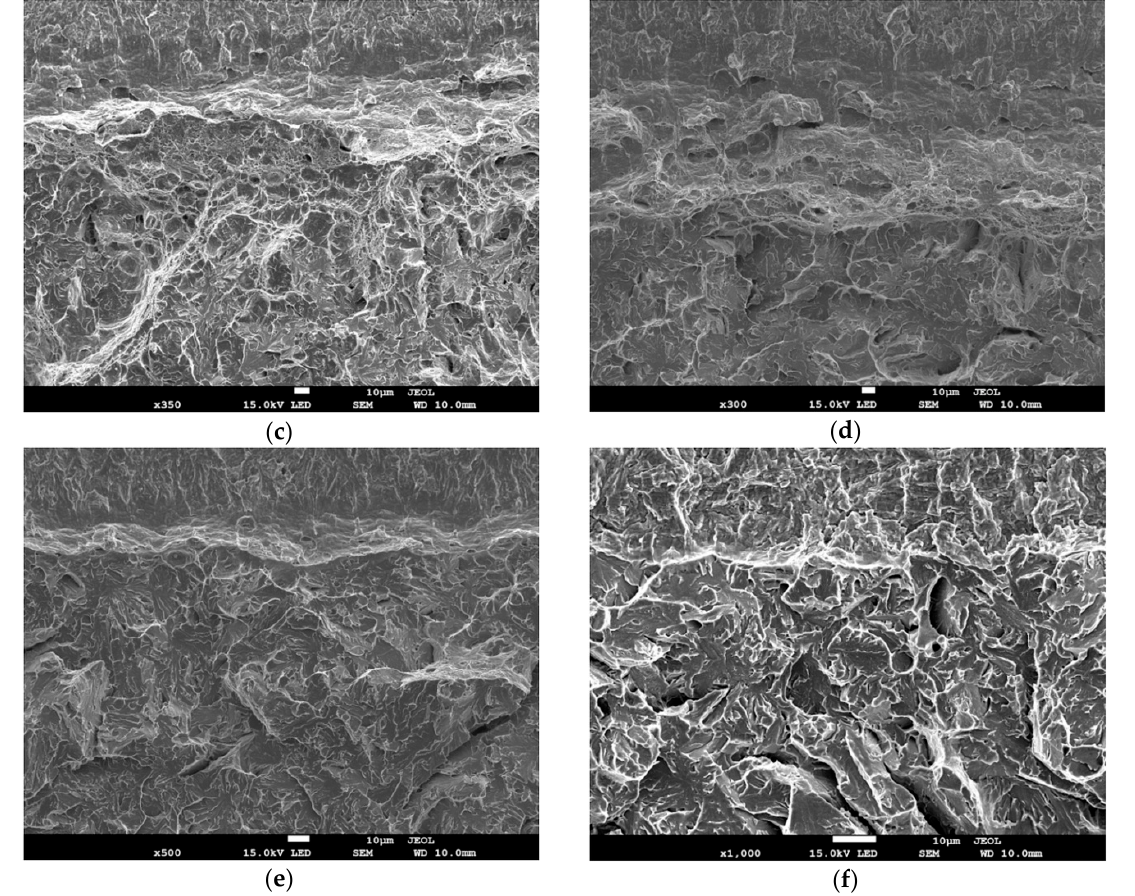
Figure 7. Microstructure of Hardox-400 steel ( a , b , c ) with inclusions and ( d ) particles of carbides precipitates in ferritic regions. The fracture surfaces of the specimens: From upper plateau ( a ) B = 4 mm, T test = 0 °C and ( b ) B = 12 mm, T test = 20 °C; from ductile-to-brittle region ( c ) B = 8 mm, T test = − 50 °C and ( d ) B = 12 mm, T test = − 20 °C; from lower plateau ( e ) B = 2 mm and ( f ) B = 12 mm, T test = − 100 °C.